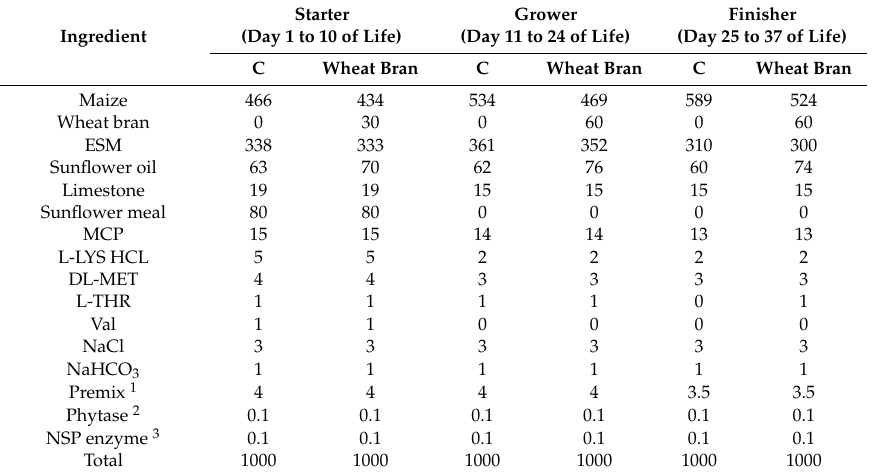
Table 1. Composition of experimental diets (g / kg as